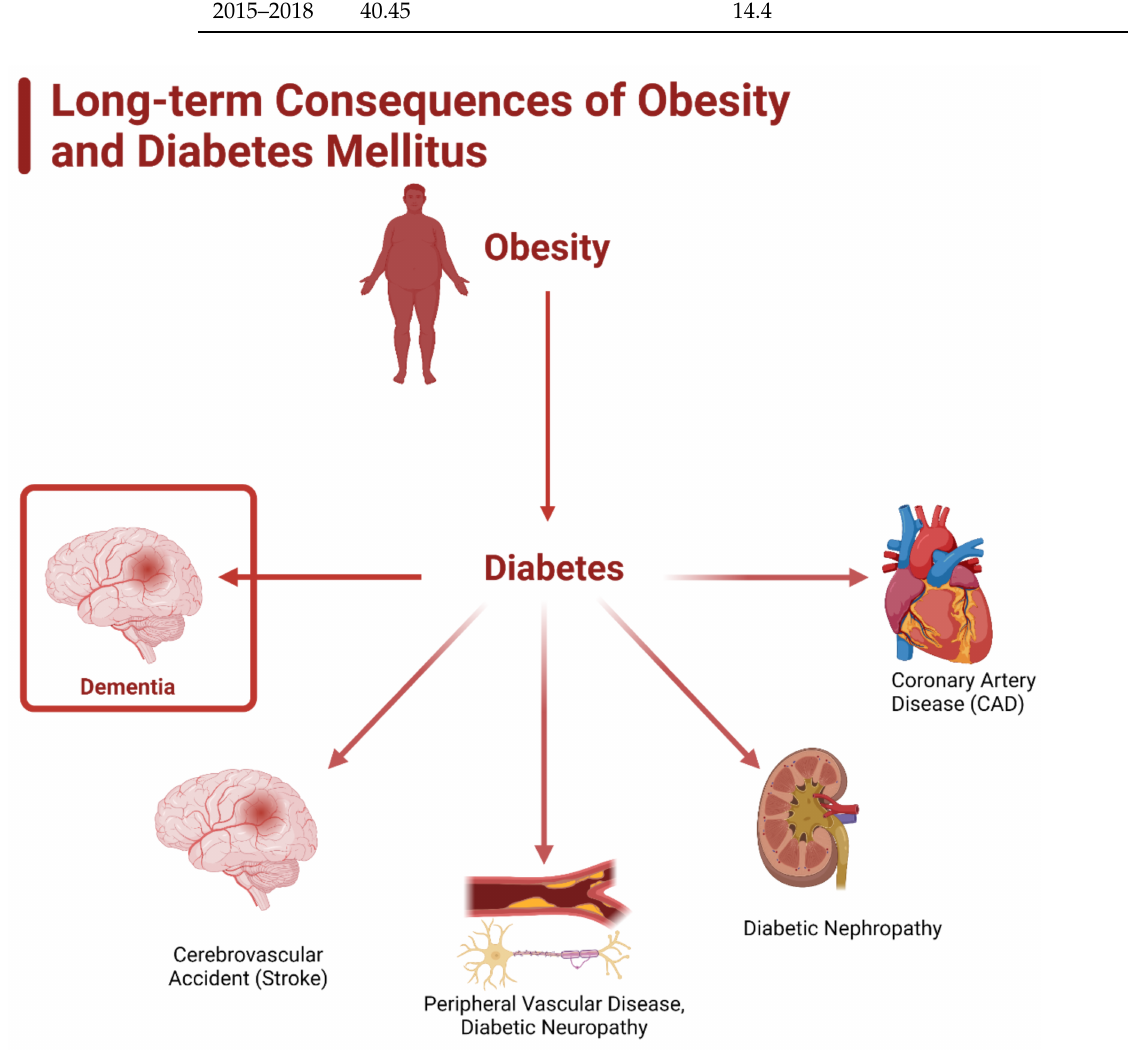
Figure 1. Long-term consequences of obesity and diabetes mellitus. Obesity is heavily linked as a causative agent of diabetes mellitus, especially type 2. Diabetes leads to the development of coro- nary artery disease (CAD), diabetic nephropathy, peripheral vascular disease, diabetic neuropathy, cardiovascular accident (stroke), and